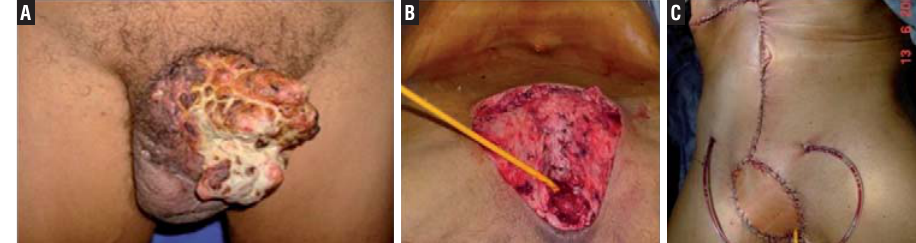
Figure 1 A-C: Patient with locally advanced penile squamous cell carcinoma submitted to emasculation and reconstruction with a vertical rectus abdominis myocutaneuos fl ap. Ceará Cancer Hospital, Fortaleza,